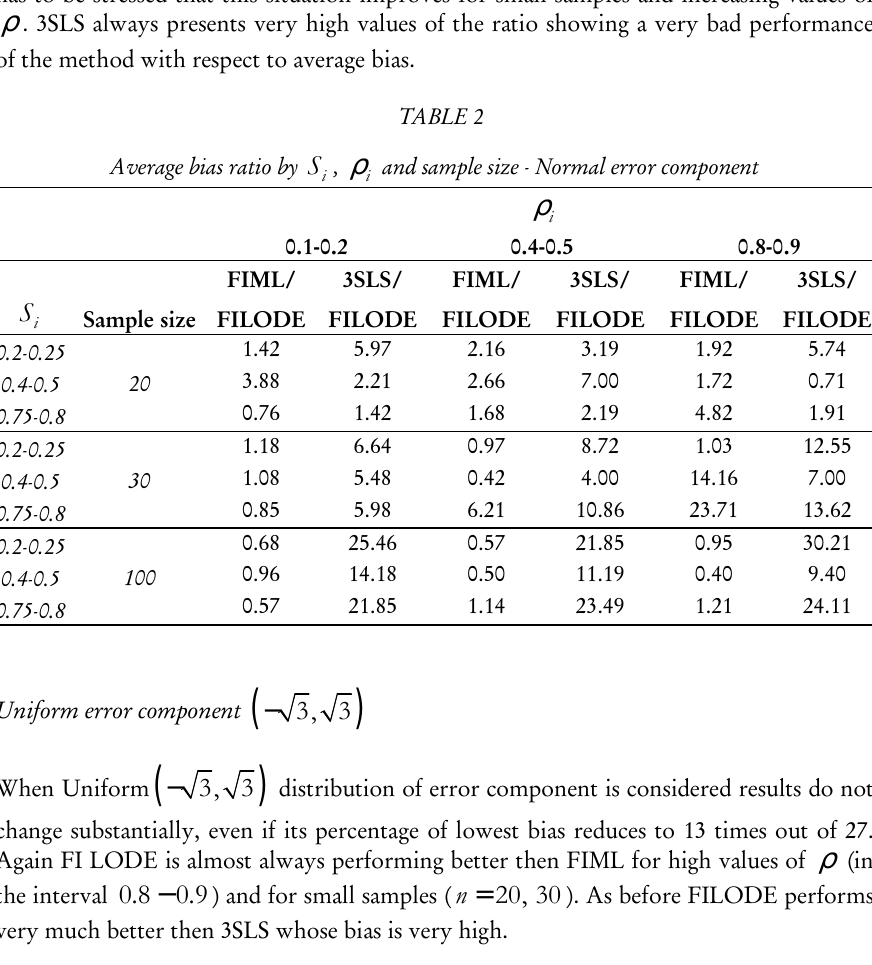
Average bias ratio by i S ,